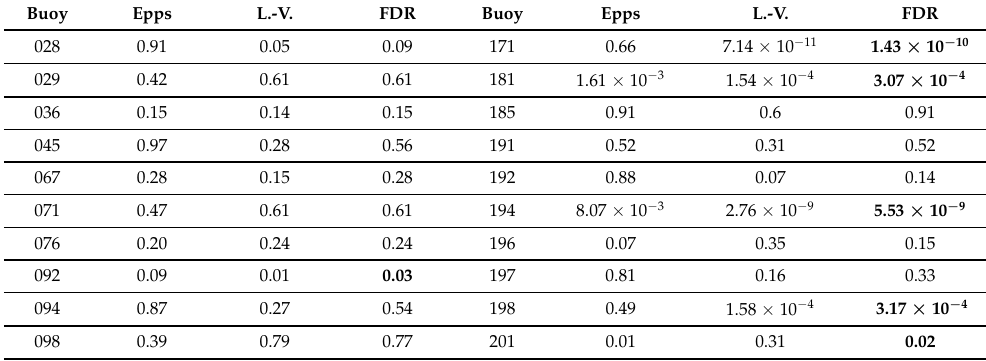
Table 4. p -Values resulting from applying the Epps test (columns 2 and 6) and the Lobato and Velasco test (columns 3 and 7) per dataset associated to each of the 55 buoys (columns 1 and 5) studied under a time period of 2.13 h in general and of 1.05 h for the buoys in B . FDR (columns 4 and 8) combination, for dependent p -values, of the two p -values per buoy, with the ones smaller than 0.05 highlighted in